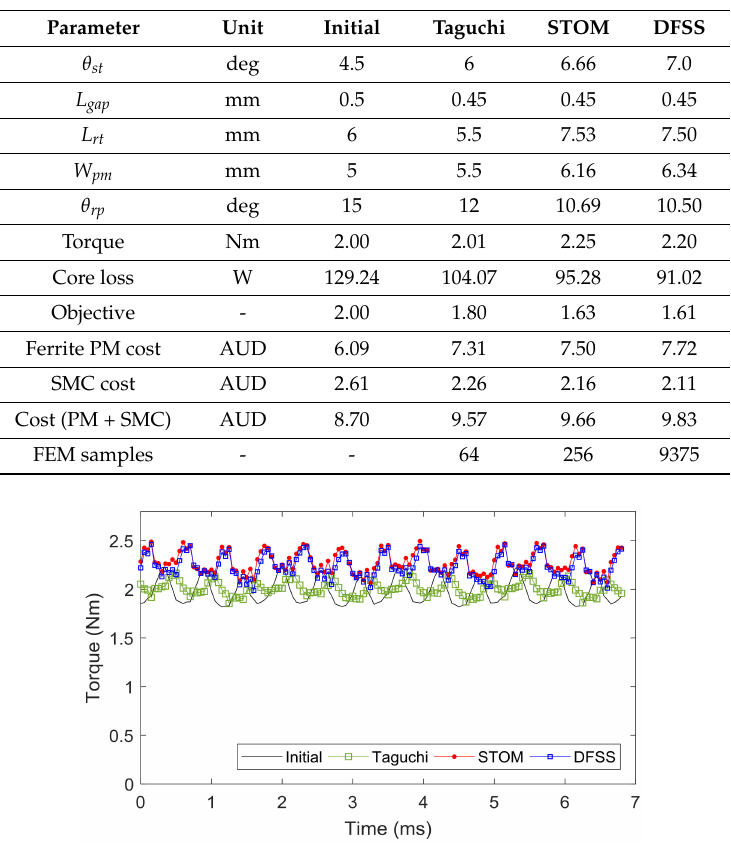
Figure 12. Torque curves for the FSPMM with four designs.